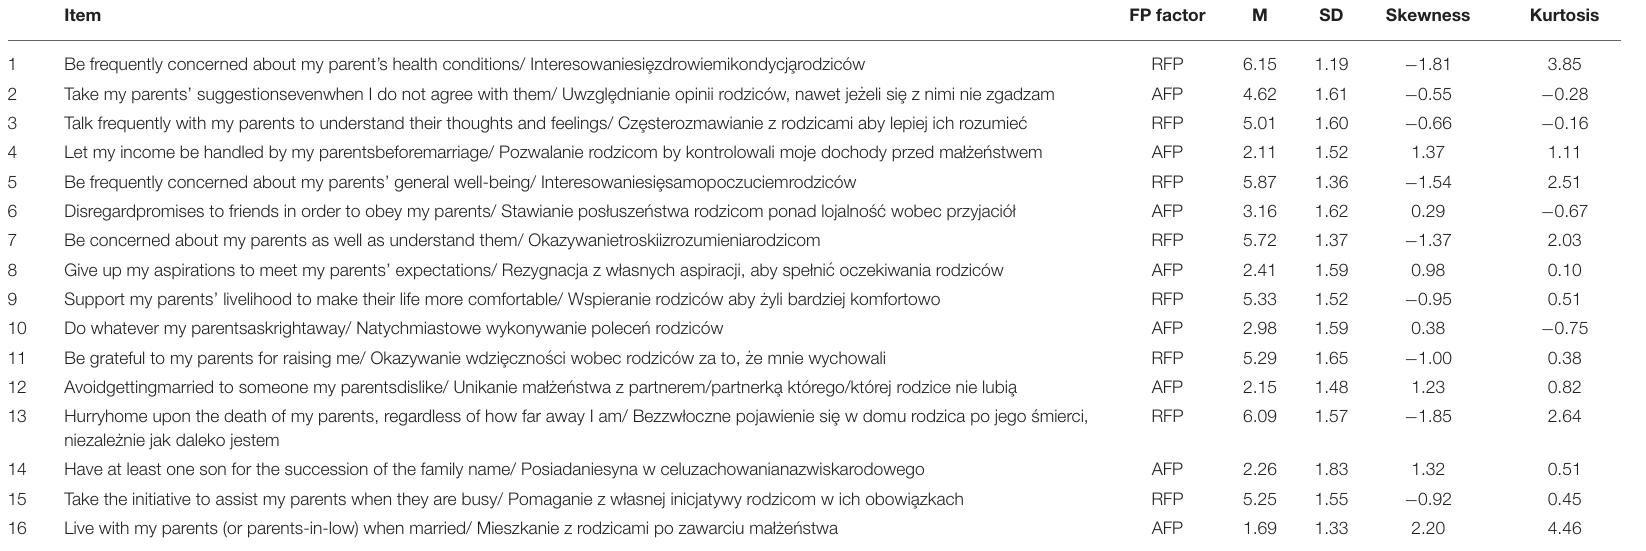
TABLE 1 | Descriptive statistics for DFPS-PL